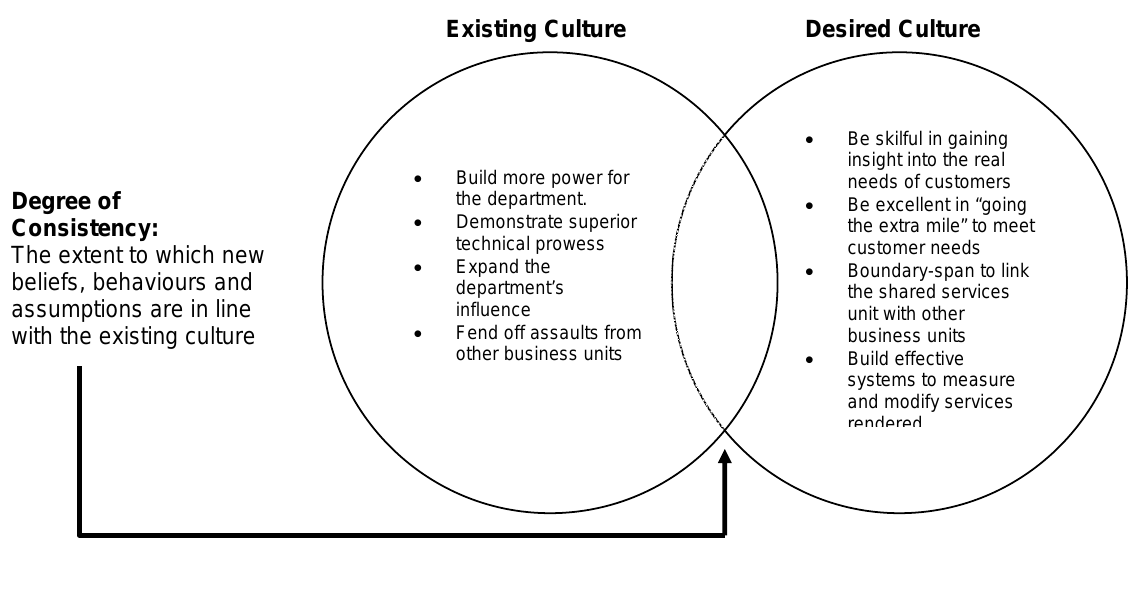
Figure 4: Existing culture to desired culture